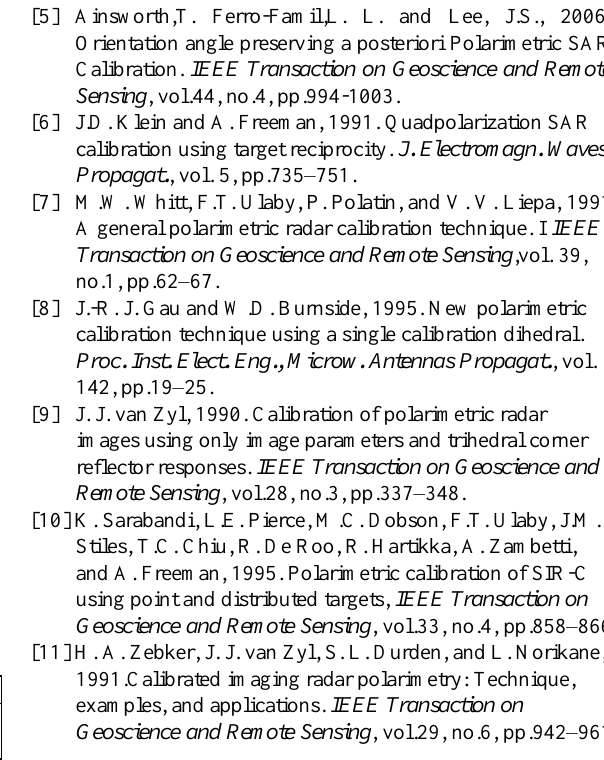
Table 2. The modified method calibration